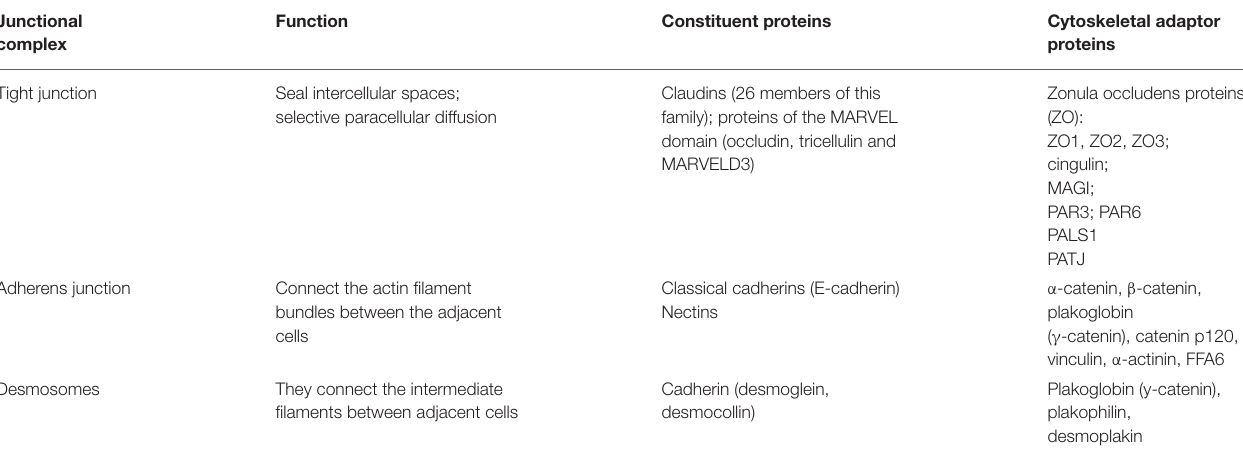
TABLE 1 | Functions and protein constituents of the junctional